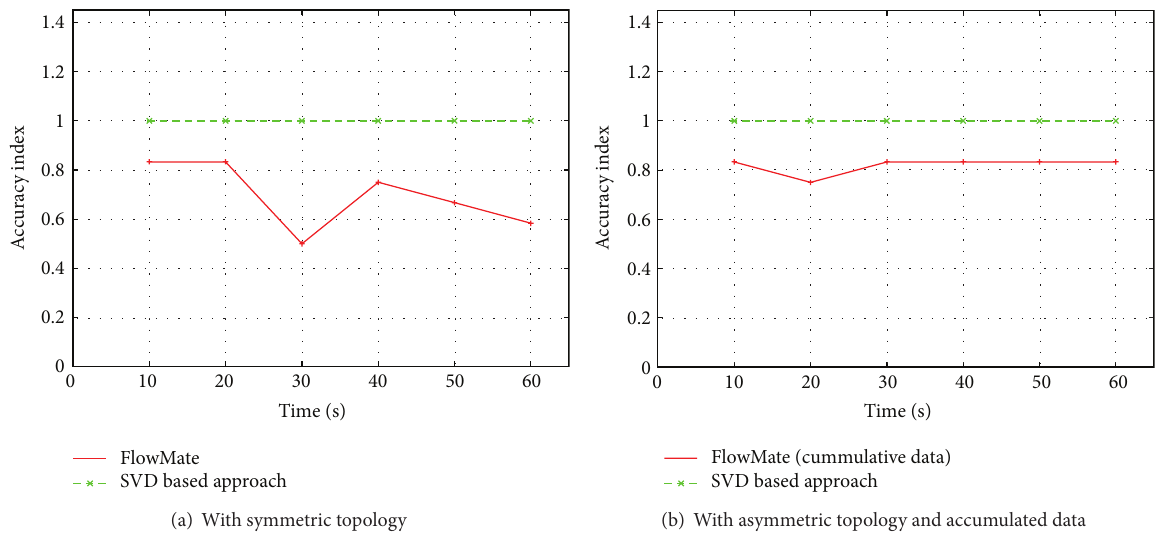
Figure 12: Comparison with